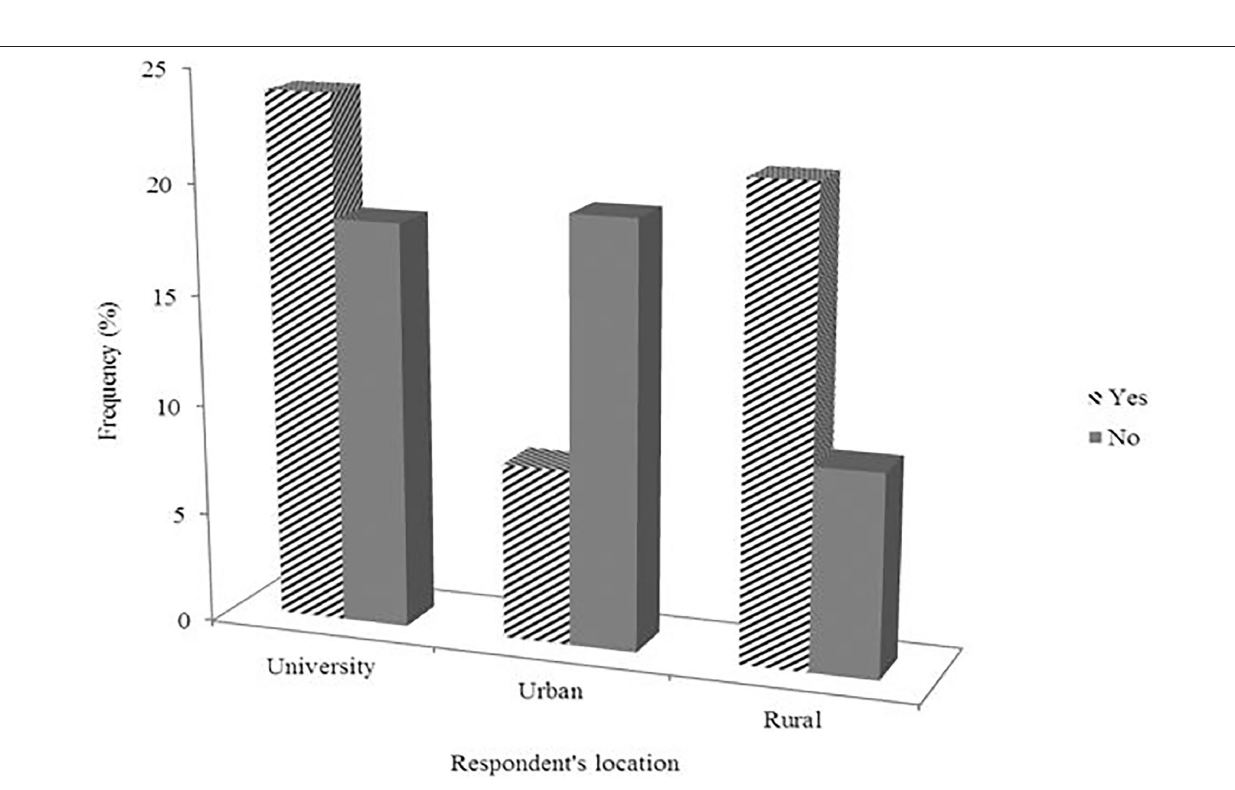
Frontiers in Sustainable Food Systems |